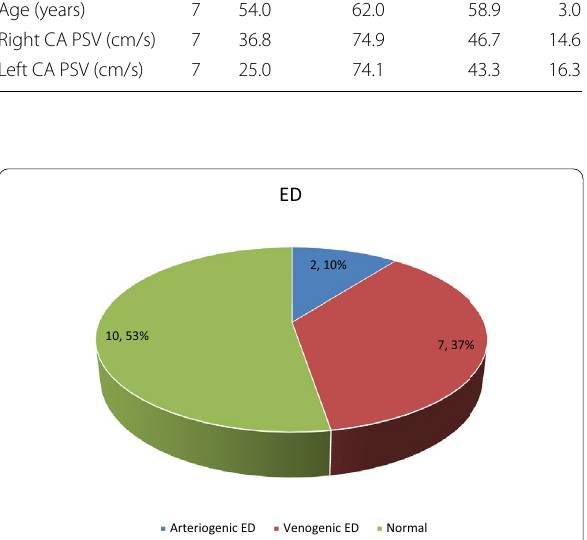
Fig. 2 Pie chart showing the pattern of Doppler findings among the patients